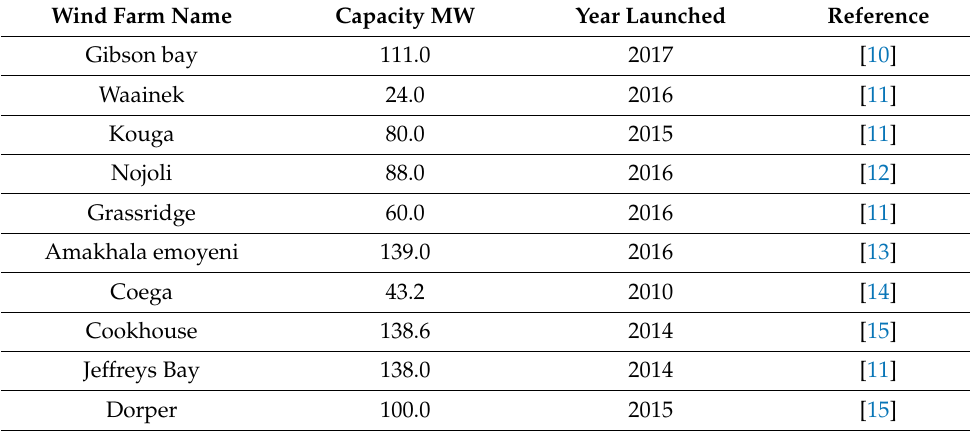
Table 2. The wind farms in the Eastern Cape.